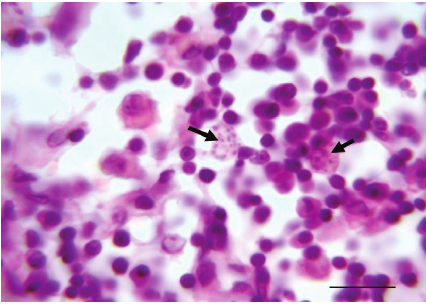
Figure 5: Histologic section of prescapular lymph node of a Leishmania -positive dog showing multiple intracytoplasmic bluish inclusions of Leishmania spp. amastigotes within macrophages (arrow), H&E, bar � 45 µ